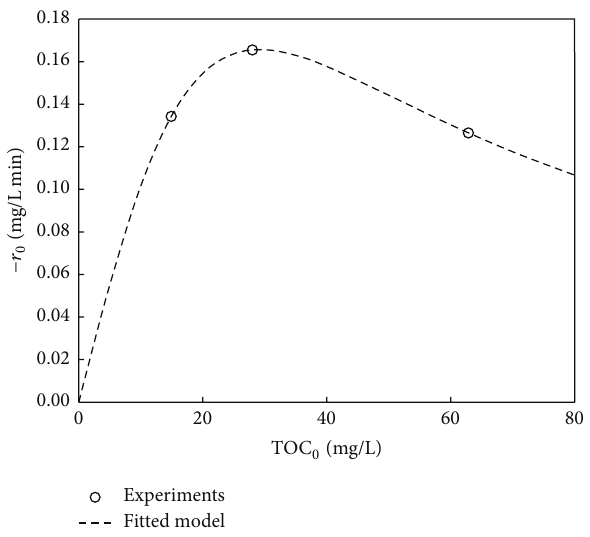
Figure 3: Initial concentration effect on the initial reaction rate of 4-CP.